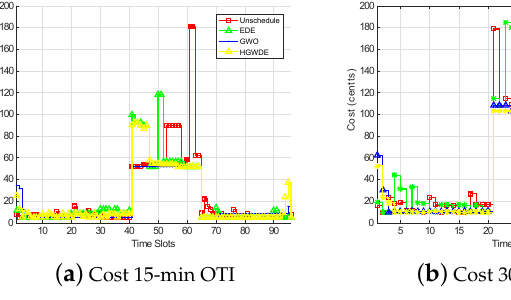
Figure 5. Cost per time slot for CPP. Table 7. Cost Comparison of Different Techniques for 24